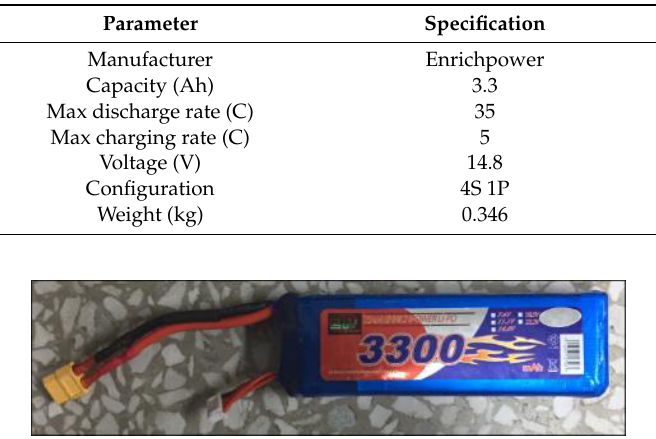
Table 3. Specifications of the LiPo battery pack.